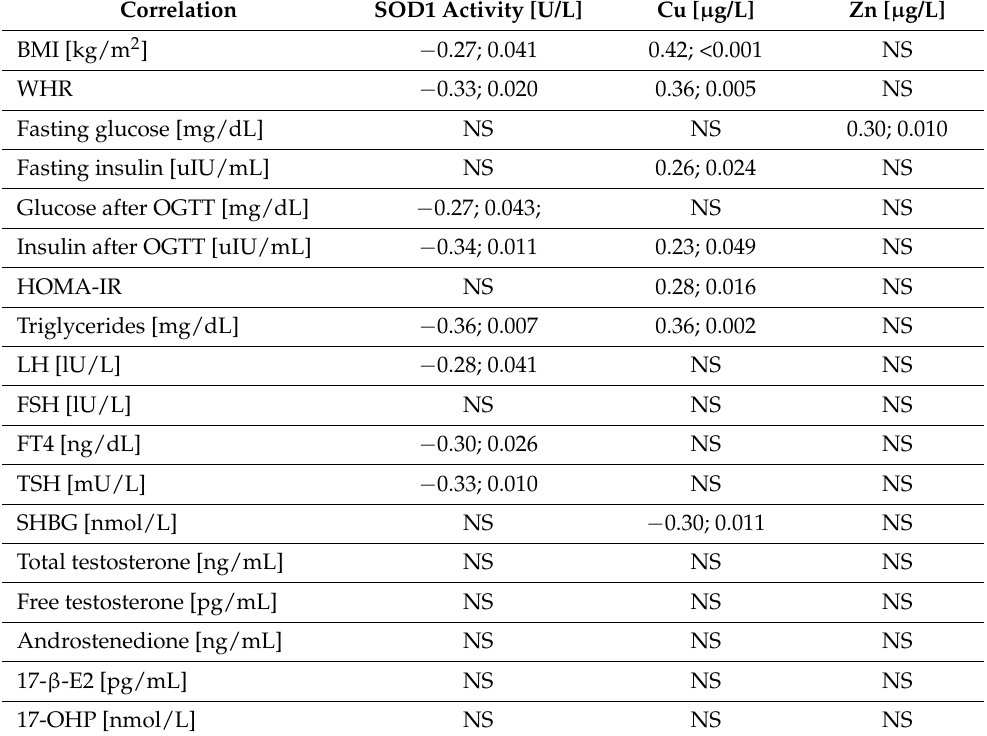
Table 4. Statistically significant correlation coefficient in whole group of PCOS women between BMI, WHR, glucose metabolism and lipid profile parameters and selected hormone concentrations with SOD1 activity and Zn and Cu